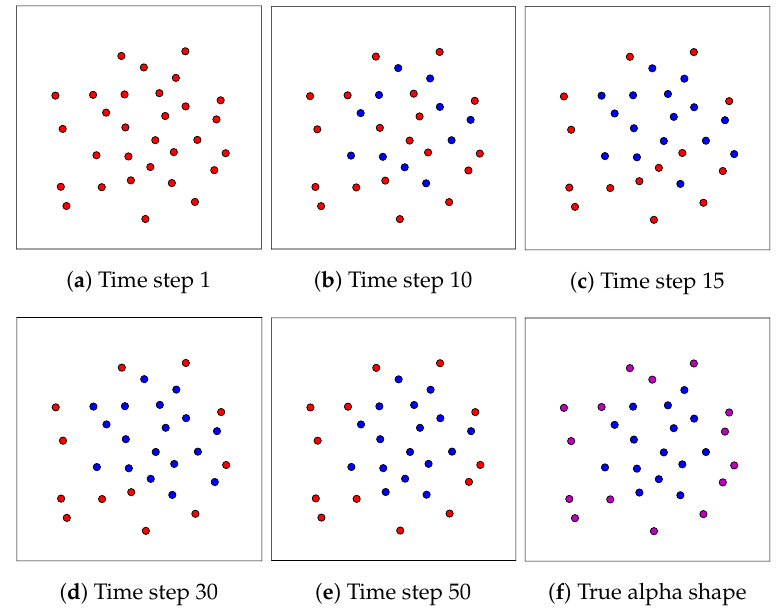
Figure 12. ( a – e ) snapshots of the borderline identification experiment at different simulation time steps. The balls represent the robots in the swarm. Robots colored in red indicate that the LED is turned on at the corresponding time step. Similarly, blue balls denote robots with the LED deactivated. Swarm topology and robot distances are preserved in the graphs. ( f ) Actual alpha shape, in purple, used as target, Note that at time step 50, once the decisions are settled, there are only 2 errors. Moreover, both errors correspond to false